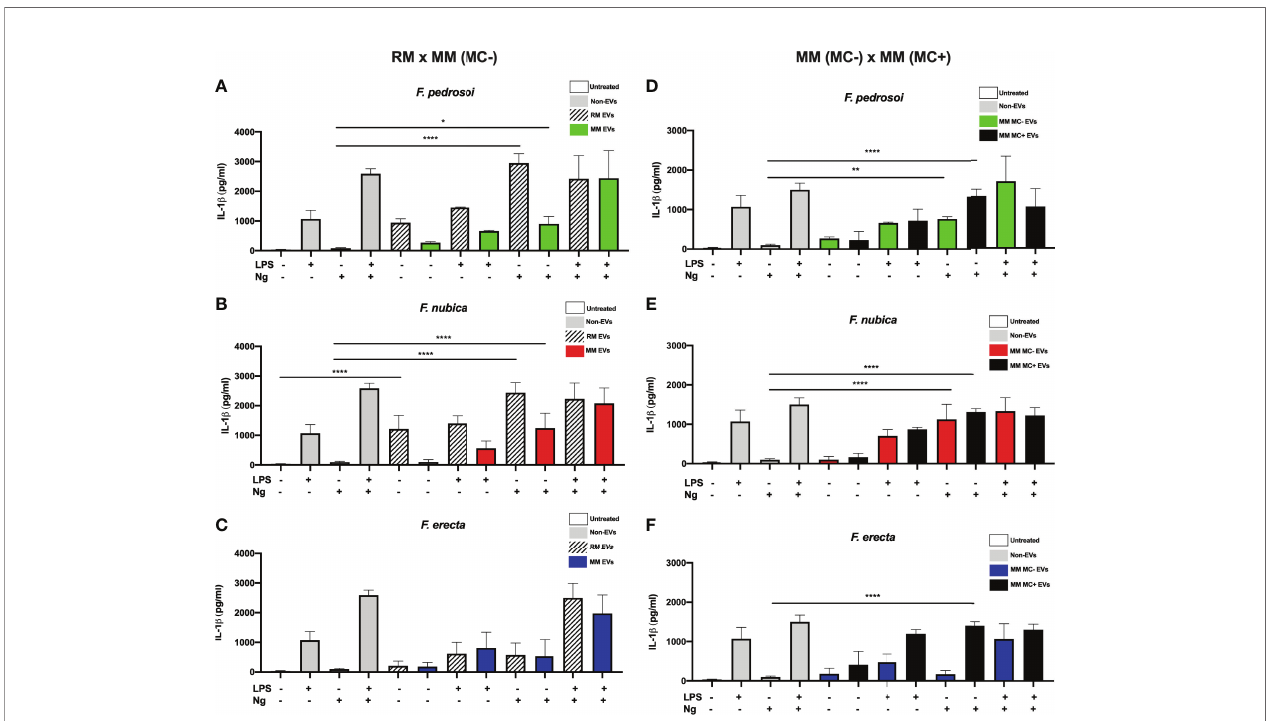
FIGURE 4 | EVs isolated from the rich medium trigger IL-1 b production possibly acting as the fi rst signal of in fl ammasome activation. MM MC- stands for minimum medium without muriform cells and MM MC+ for minimum medium in the presence of muriform cells. EVs (80 ng/mL of sterol content) from F. pedrosoi (A, D) , F. nubica (B, E) , and F. erecta (C, F) grown in RM, MM MC-, and MM MC+ were incubated with 1x10 6 BMDMs in the presence or absence of lipopolysaccharide (LPS, 500 ng/mL) and/or nigericin (Ng, 20 m M) for 24h. IL-1 b secretion was analyzed by enzyme-linked immunosorbent assay (ELISA). For all plots, * indicates p < 0.05, ** indicates p < 0.01, **** indicates p < 0.0001 compared to negative and positive controls according to one-way analysis of variance (ANOVA). The results presented in this work refer to a representative triplicate group experiment of at least two independent